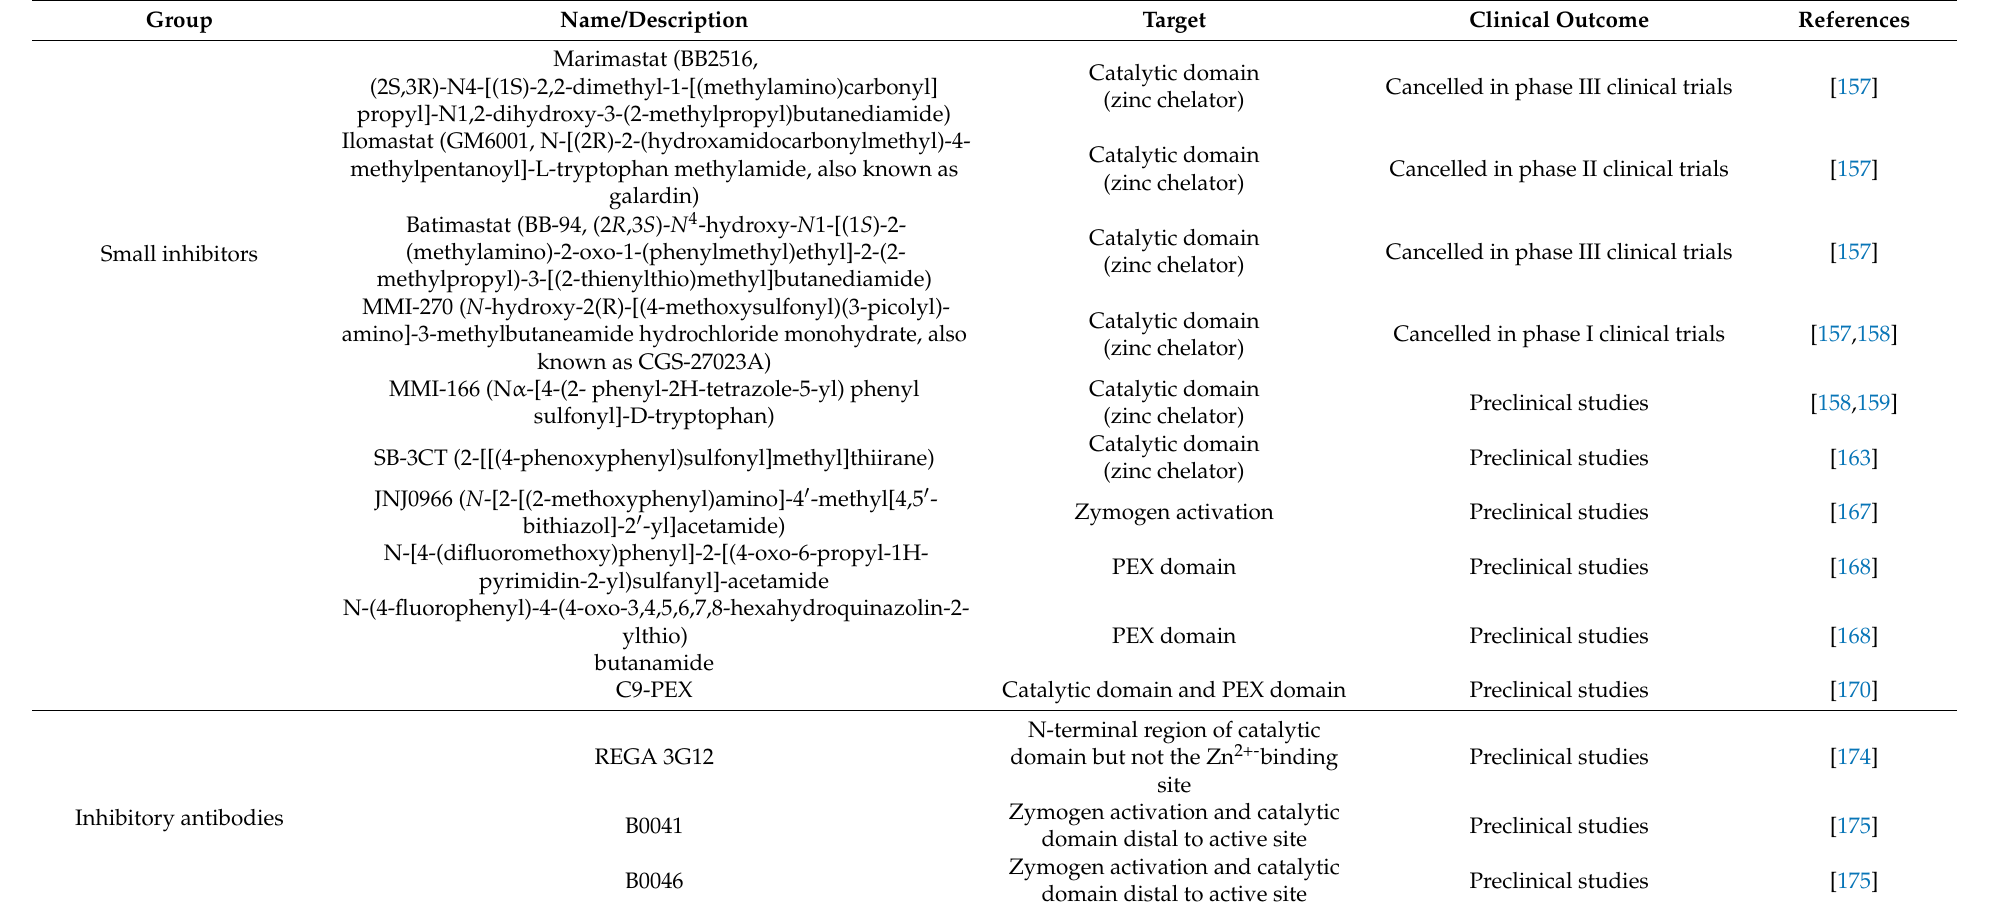
Table 2. Specificity and clinical research of selected MMP9 inhibitor